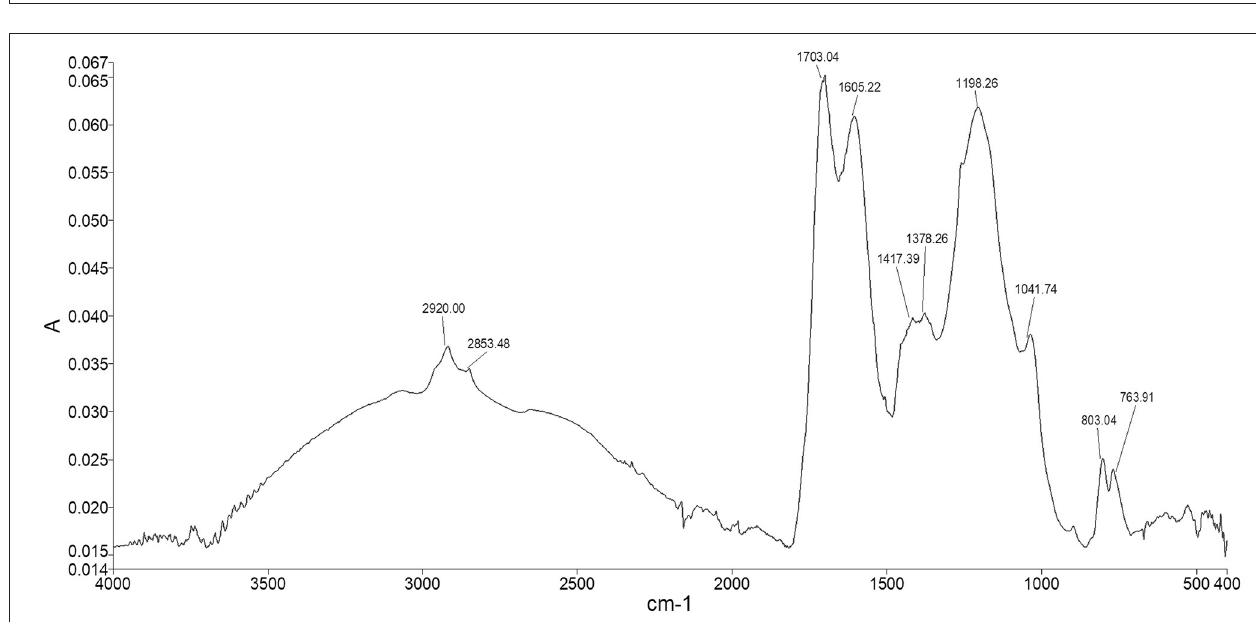
FIGURE 6 | Idaho HA FT-ATR